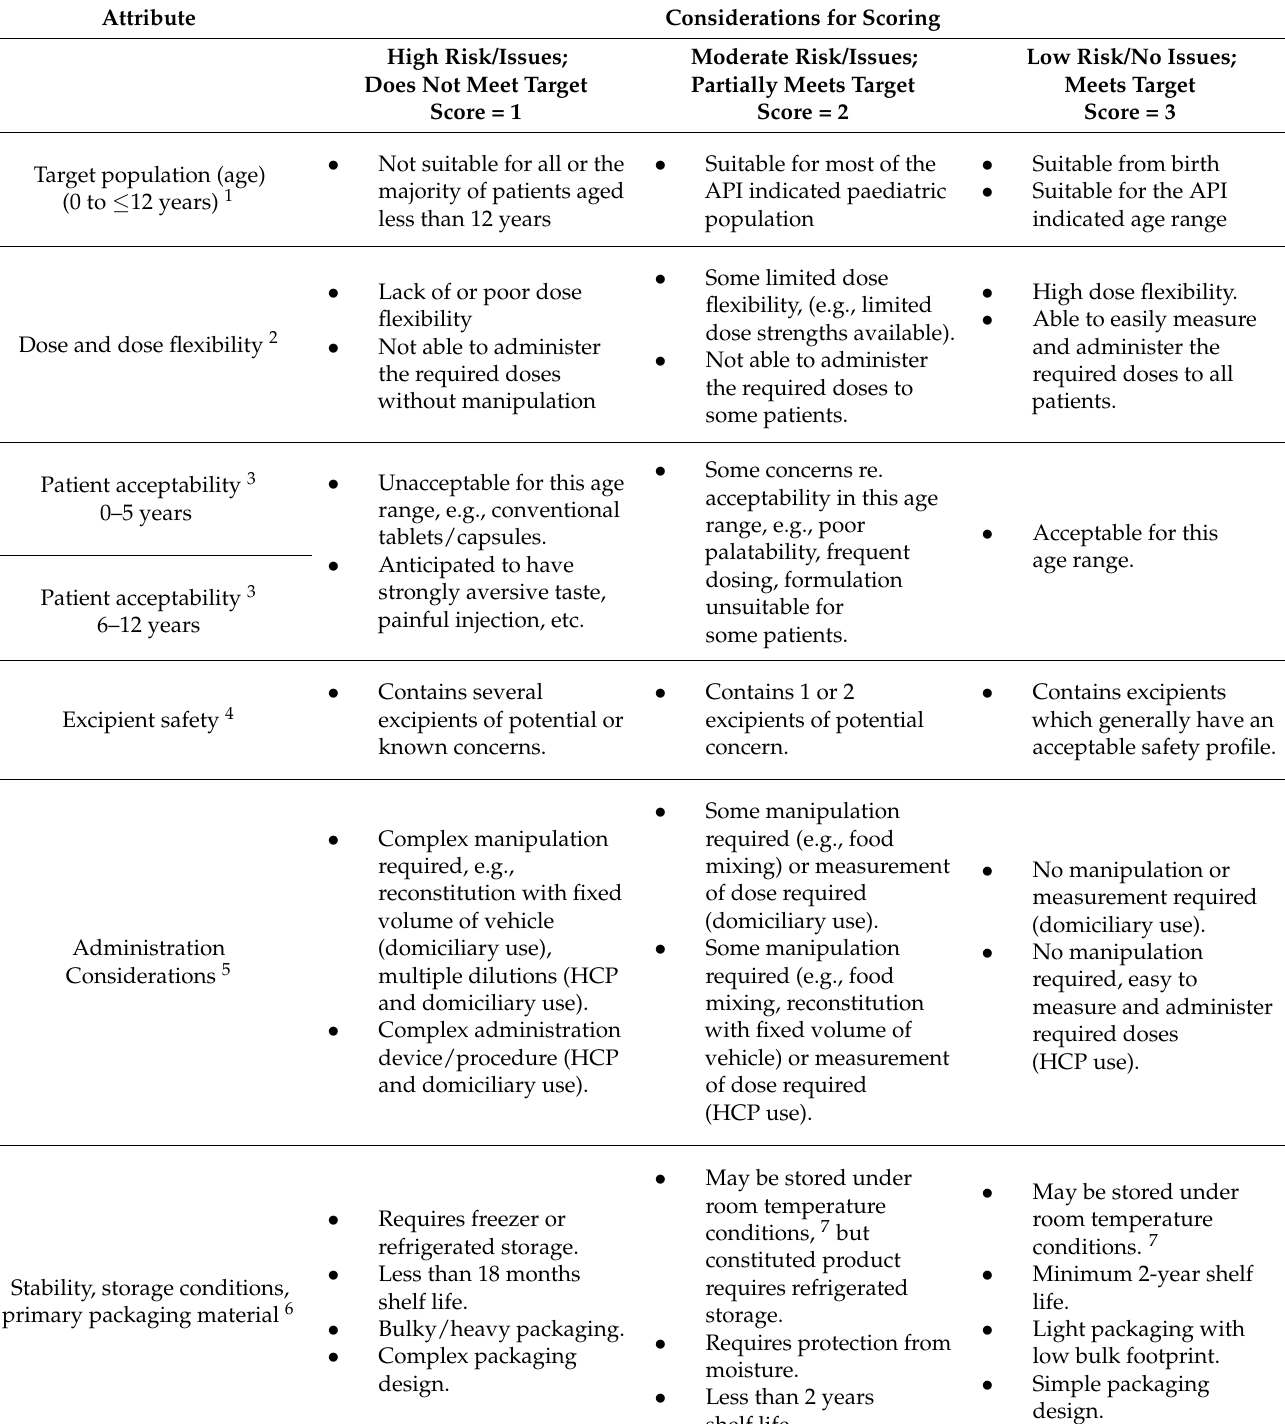
Table 2. Paediatric Quality Target Product Profile tool scoring